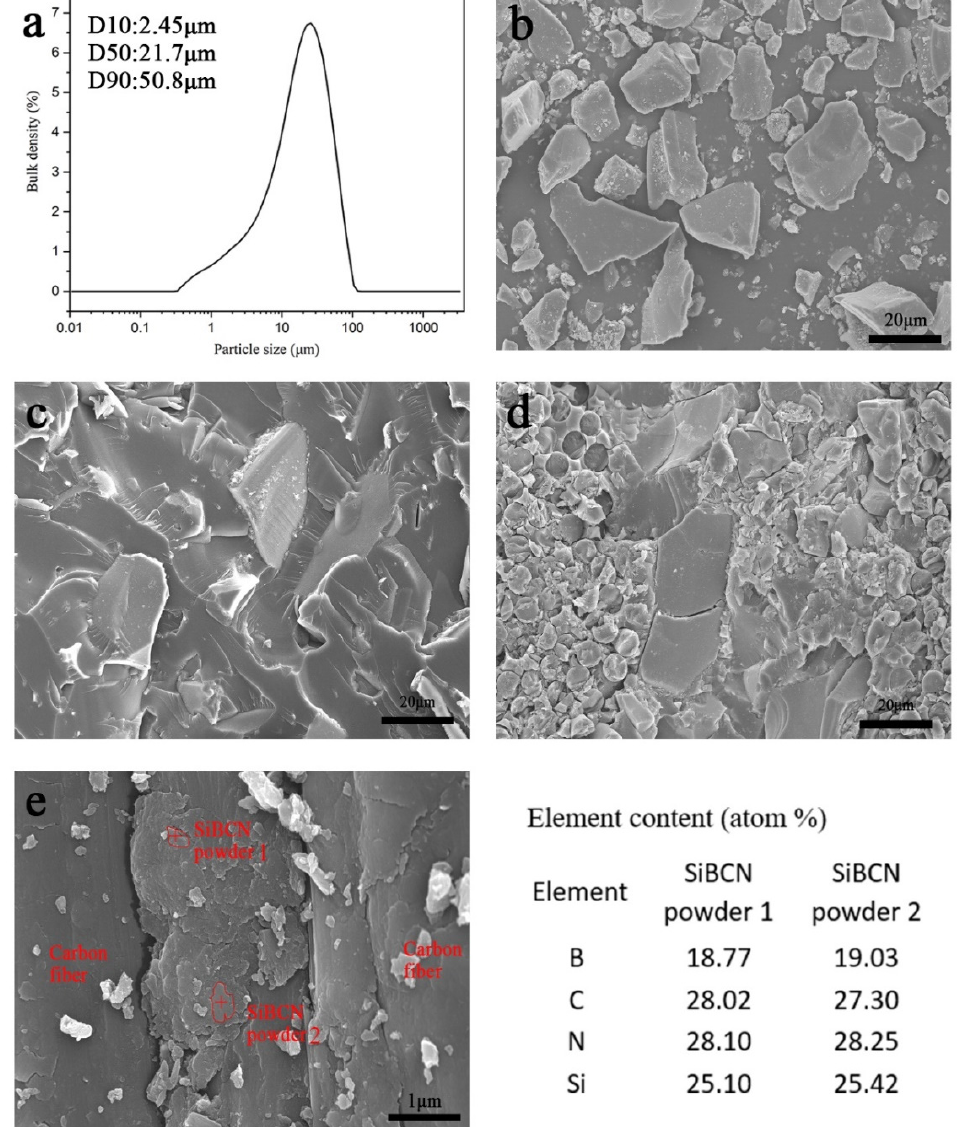
Figure 1. Particle size distribution ( a ) and scanning electron microscopy (SEM) image ( b ) of SiBCN powder, SEM images of the cured SiBCN phenolic resins ( c ) and the SiBCN–phenolic/C composites ( d , e ).